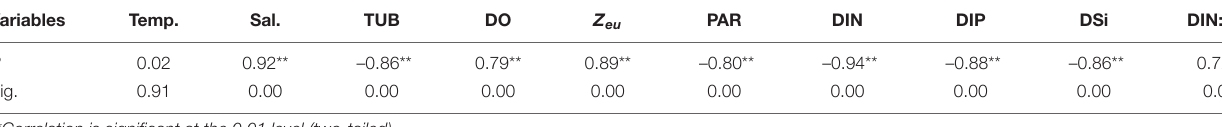
TABLE 3 | Pearson correlation between PER and environmental variables. Variables Temp. Sal. TUB DO Z eu PAR DIN DIP DSi DIN:DIP